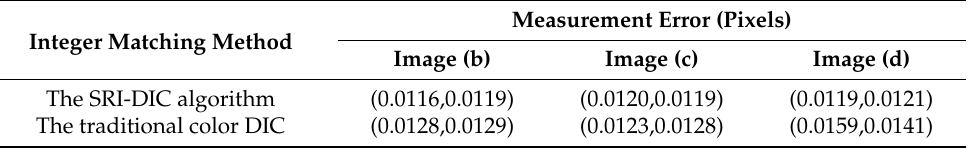
tional color DIC tional color DIC algorithm.